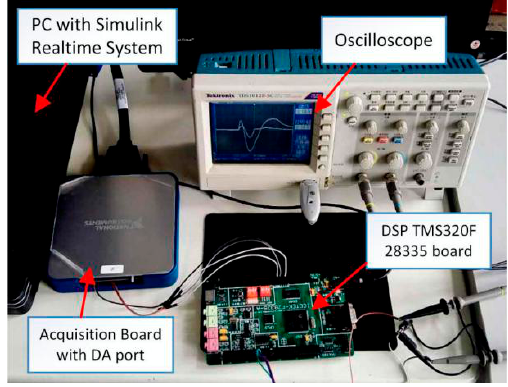
Figure 20. Experimental setup.